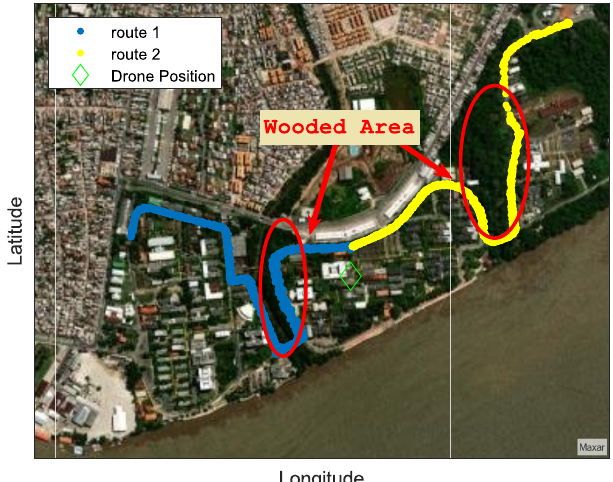
Figure 5. Measurement